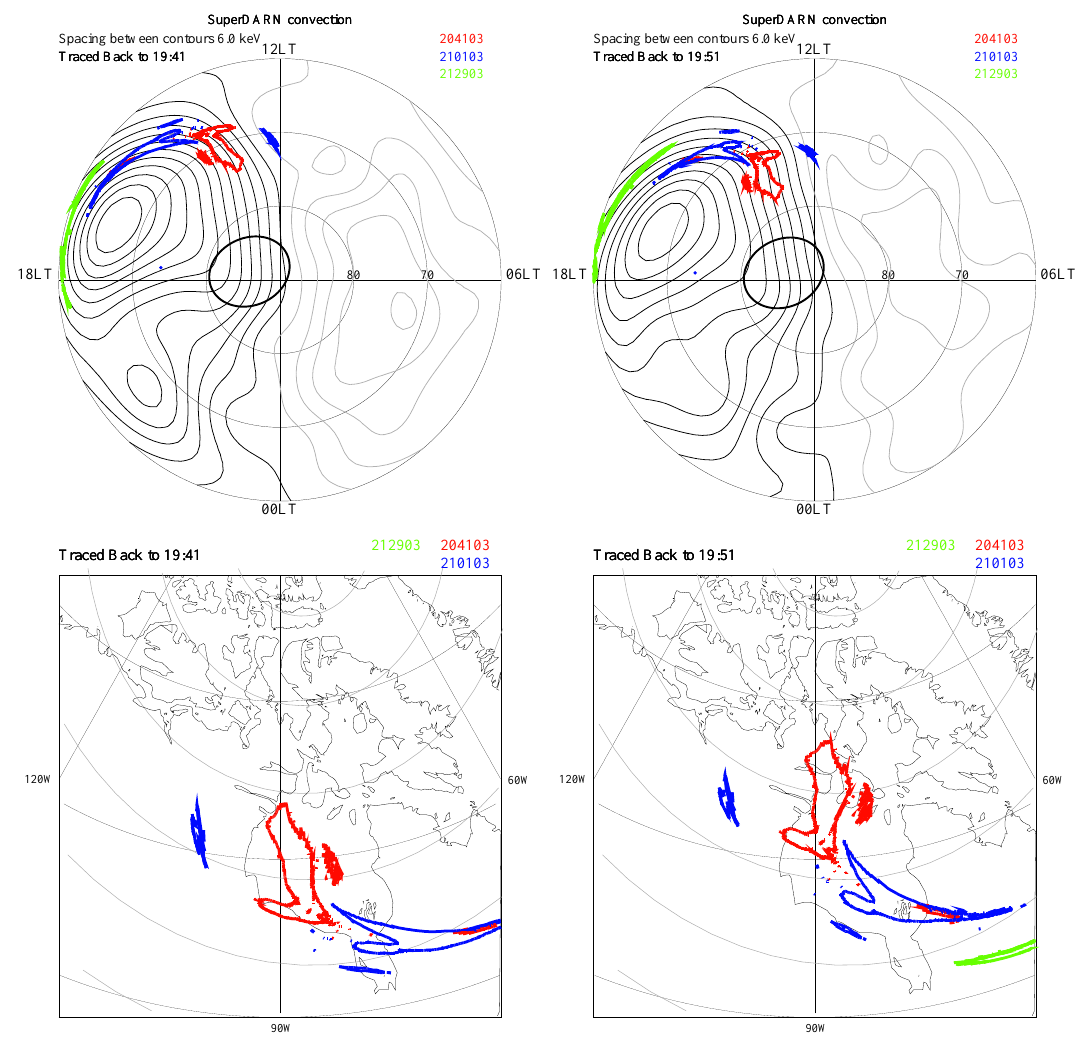
Figure 9. Trajectory analysis of the patches observed at Qaanaaq on 20 November 2003 at 20:41 (red), 21:01 (blue), and 21:29UT (green). The images were traced backward in time to 19:41 and 19:51UT. The top panels show the patches in a CG system. The lower panels show the same information in geographic coordinates. The gray lines in the lower panels indicate constant magnetic latitudes between 85 and 70 ◦